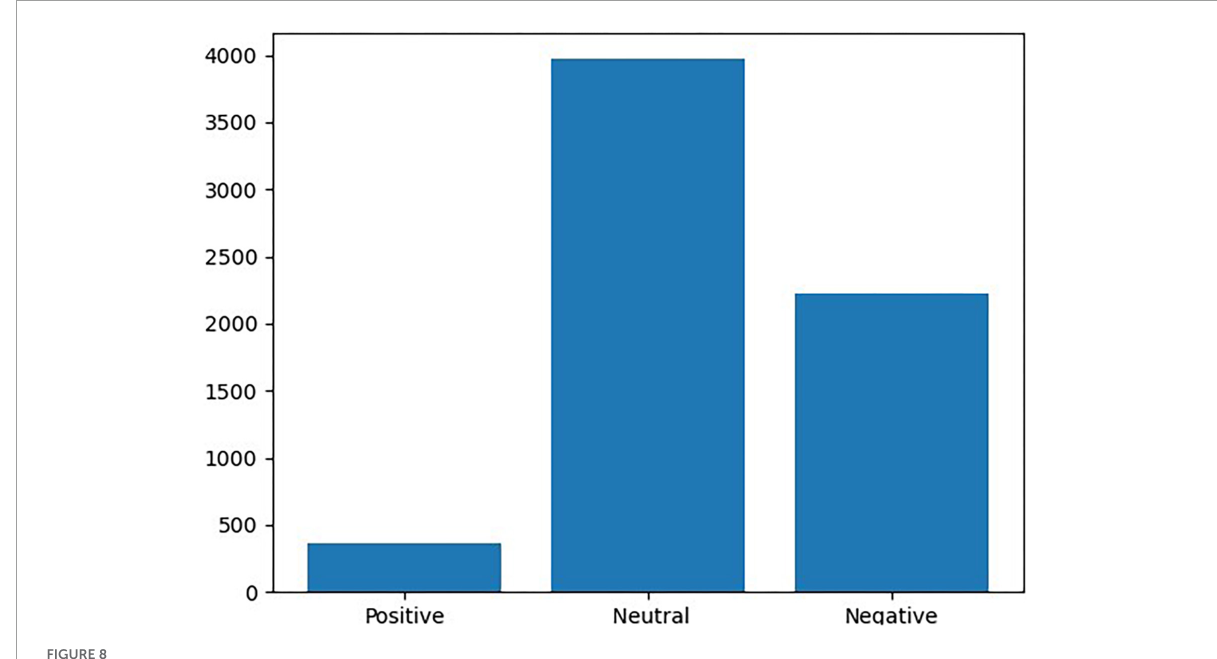
FIGURE8 Frequency of positive labels and negative labels.